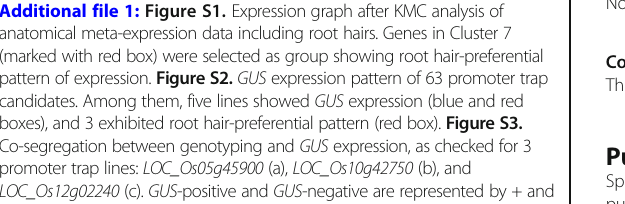
to rice OsUbi5 transcript level. Figure S5. New motifs discovered in 409 root hair-preferential genes, based on MEME analysis. Figure S6. Expression graph after KMC analysis of anatomical meta-expression data in Arabidopsis . Clusters 2, 4, and 6 (in red boxes) show root hair-preferential expression patterns. Figure S7. Heatmap for expression profiles of root hair-preferential genes in Arabidopsis . Yellow, high expression; dark-blue, low expression. Figure S8. Functional gene network associated with root hair-preferential genes in rice, as indicated by large circles with red boundaries. Six functionally characterized genes are named. Interactions between nodes with PCC values >0.5 are rep- resented by red lines. (DOCX 2500 kb)